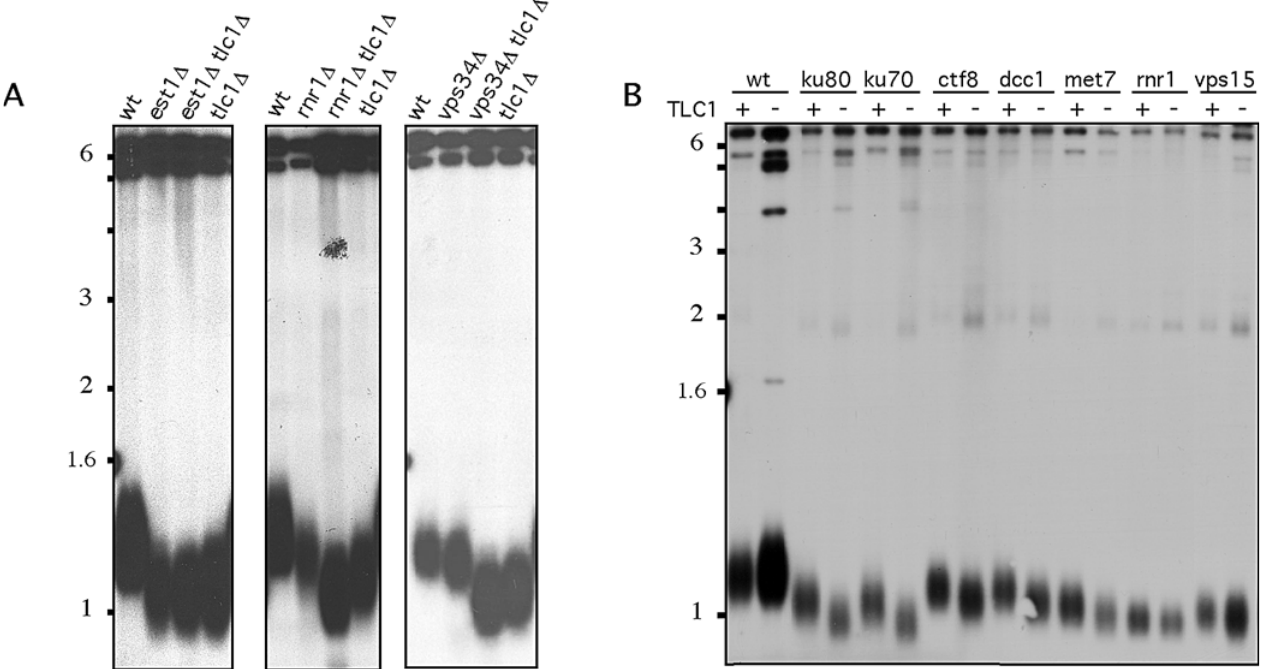
Figure 4. The Lack of TLM Genes Accelerates Telomere Loss in the Absence of Telomerase (A) Mutants in genes required for dNTP synthesis (RNR1) and VPS (VSP34) exhibit accelerated telomere loss in the absence of telomerase. This shows telomere length of single tlc1, tlm, and double tlc1 tlm mutants 20 doublings after germination of TLC1/tlc1 TML/tlm heterozygous diploids. Telomere length in est1 tlc1 double mutants is the same as the telomere length in tlc1 or est1 single mutants. Telomere length of double rnr1 tlc1 and vps34 tlc1 mutants is shorter than the telomere length of single rnr1, vps34, or tlc1 singe mutants. (B) The loss of telomeric DNA in the absence of telomerase is accelerated in dNTP (rnr1, met7), sister chromatid cohesion (ctf8, dcc1), and VPS (vps15) mutants. Single tlc1 or double tlc1 tlm mutants containing galactose-inducible TLC1 plasmid (GAL-TLC1) were grown in galactose medium (TLC1 þ ) or in glucose (TLC (cid:1) ) medium for five cell divisions. Single tlc1 mutants do not have significant telomere loss while the telomere loss is easily appreciated in the double tlc1 tlm